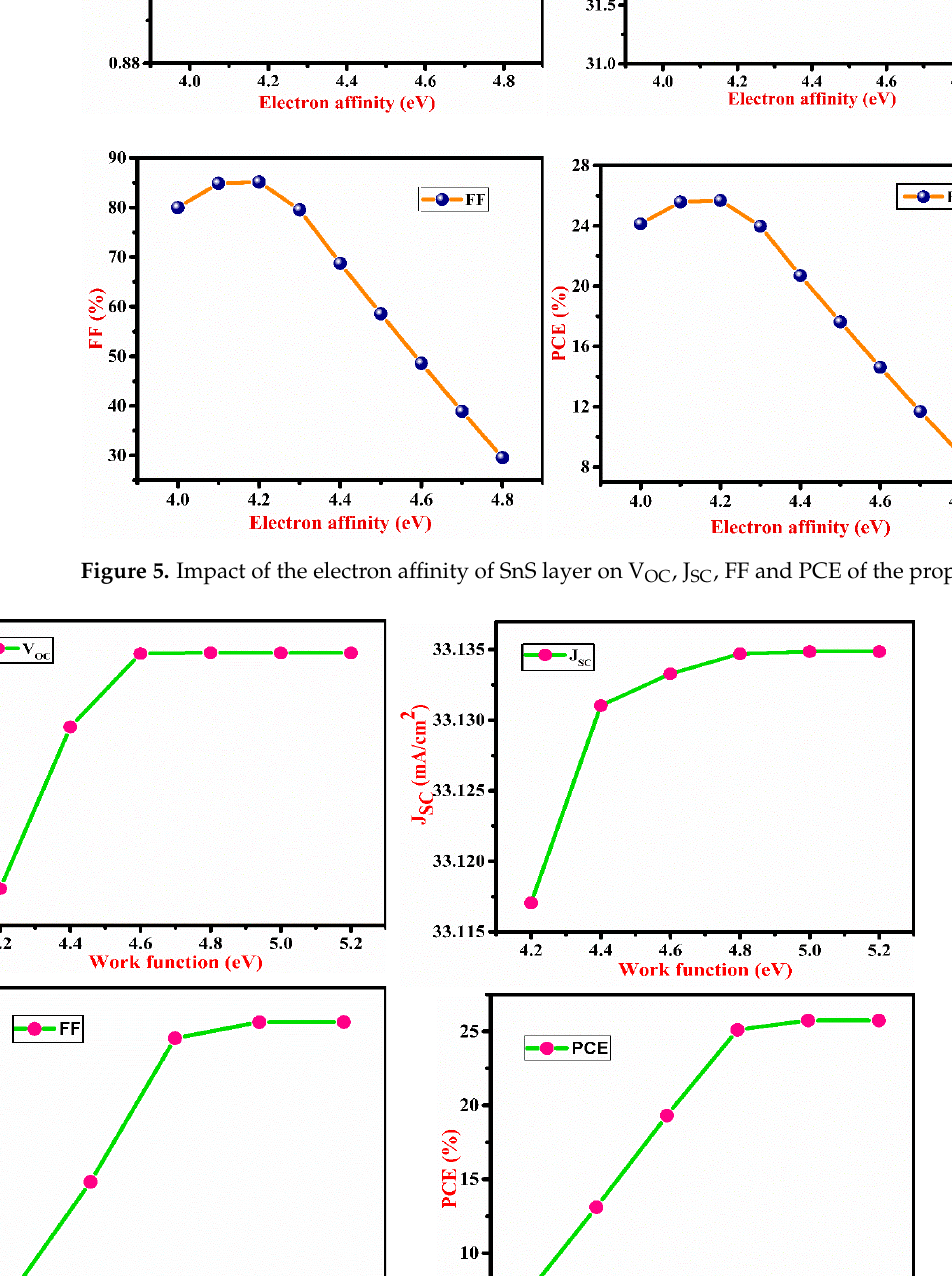
OC , J SC , FF and PCE of the proposed